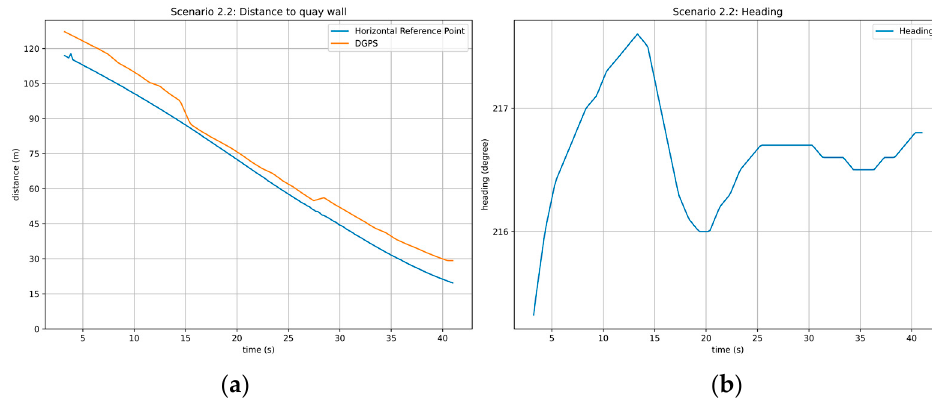
Figure 18. Scenario 2.2 horizontal distance to quay wall ( a ) and ships heading ( b ).